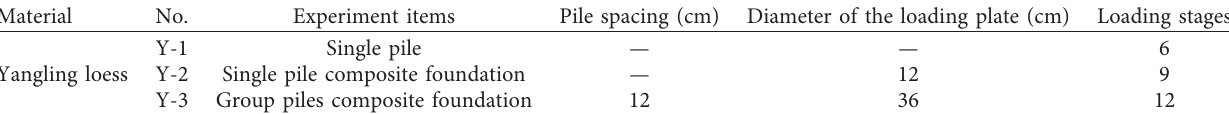
Table 3: Experiment protocol for the laboratory model test of the composite foundation. Material